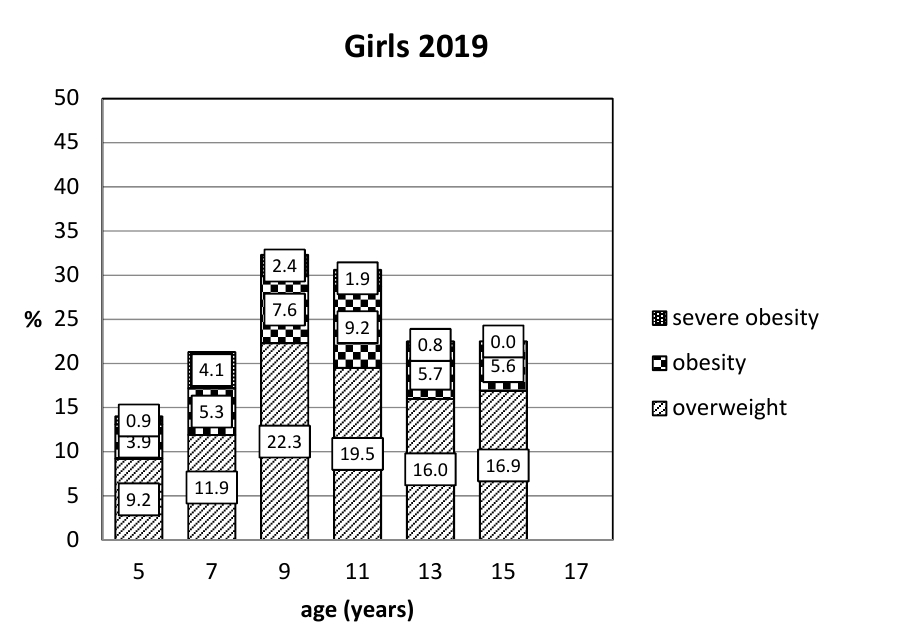
Figure A1. Prevalence of overweight, obese, and severely obese boys in 2019.